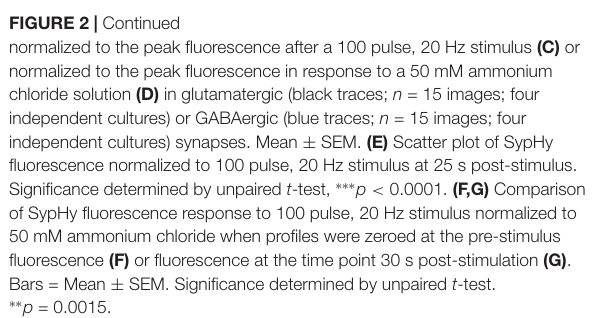
have a faster proton efflux rate than isolated